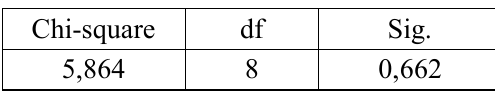
Tabel 11. Hosmer dan Lemeshow Test Chi-square df Sig. 5,864 8 0,662 Sumber: Hasil Pengolahan Data SPSS 12.0